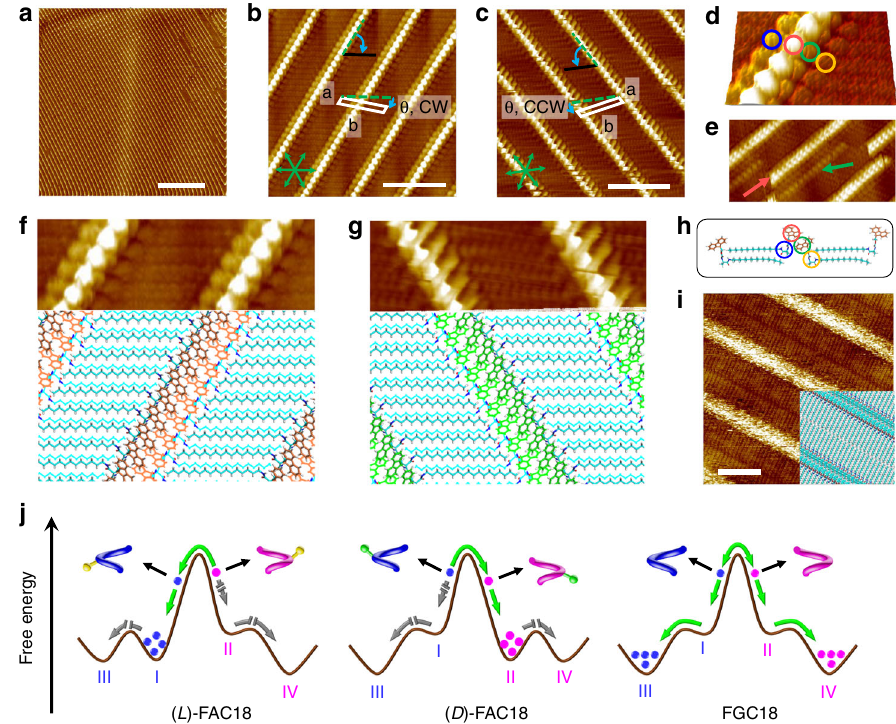
Fig. 4 Supramolecular bilayers of the pure enantiomers. a Large-scale STM image of the lamellar network of ( L )-FAC18 ( I set = 200 pA, V bias = − 800 mV). b , c High-resolution STM images of the enantiomorphous structures of ( L )-FAC18 ( I set = 200 pA, V bias = − 800 mV) and ( D )-FAC18 ( I set = 200 pA, V bias = − 600 mV), respectively. The green arrows and dashed lines indicate the orientation of main symmetry axes of the underlying graphite lattice. The white parallelograms outline the unit cells of surface structures, while the black lines indicate the orientations of alkyl chains. CW and CCW organizational chirality is de fi ned by the angle between the HOPG reference axis and the unit cell vector b . d 3D view revealing four types of bright protrusions (outlined by circles in different colors). e STM image of a defect where a bright strand is separated into two isolated ones (indicated by red and green arrows). f , g Small-scale STM images and energy-minimized CW and CCW structures of the bilayer arrangement of ( L )-FAC18 and ( D )-FAC18, respectively, with unit cell dimensions (nm) 0.50 × 3.55, γ = 70°. The top and bottom layers are displayed in stick and line representations, respectively. h Side view of the bilayer. The circles outline the moieties that contribute to the different bright features in d ; i STM image and structural model of the monolayer structure of FGC18 ( I set = 10 pA, V bias = − 600mV). j Self-assembly energy landscapes of ( L )-FAC18, ( D )-FAC18, and FGC18. The green arrows indicate the active pathways involved in the formation of surface structures, while the gray arrows show the pathways that have been predicted by simulations but are not observed by STM, i.e. the so-called inactive pathways. Scale bars: a 50 nm; b , c , i 5